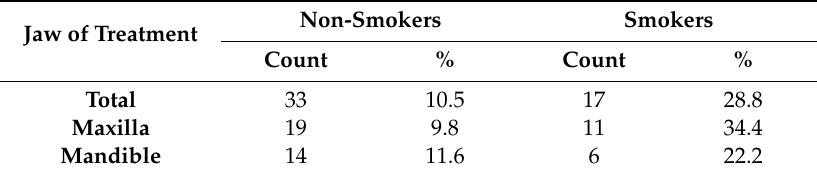
Table 6. Distribution of implant with peri-implantitis in regard to jaw type and smoking